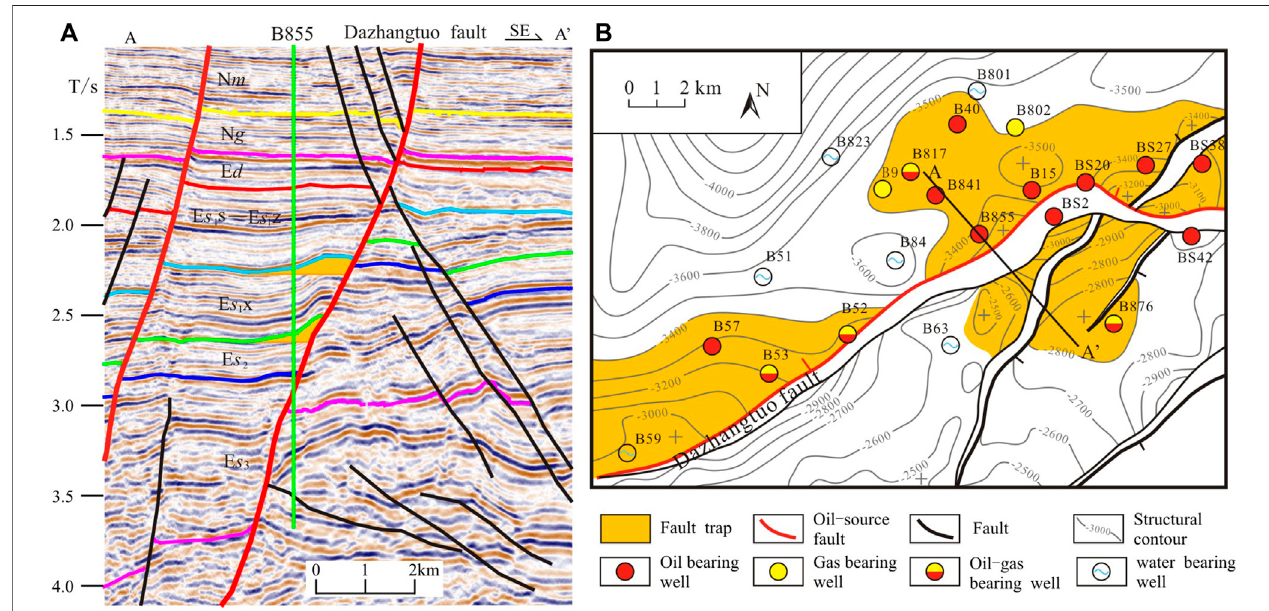
FIGURE 5 | Characteristics of the Dazhangtuo fault. (A) Seismic section of the Dazhangtuo fault, location of the section shown in Figure 5B . (B) Oil and gas distributionoftheBan2oilgroupandfaulttrapsaroundtheDazhangtuofaultintheQikouSag.N m =MinghuazhenFormation;Ng=GuantaoFormation; Ed=Dongying Formation; E s 1 s, E s 1 z, and E s 1 x = the upper, middle, and lower sub-member of the fi rst member of the Shahejie Formation; E s 2 , E s 3 = the second, third member of the Shahejie